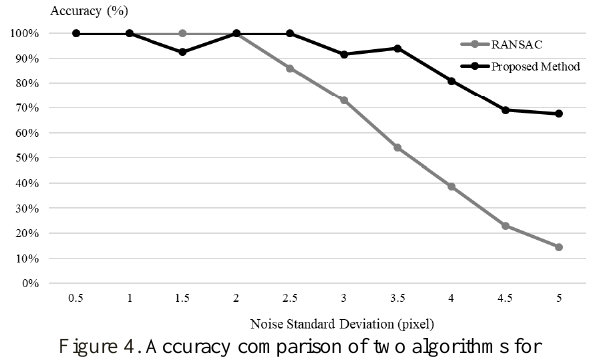
Figure 4. Accuracy comparison of two algorithms for processing noisy data